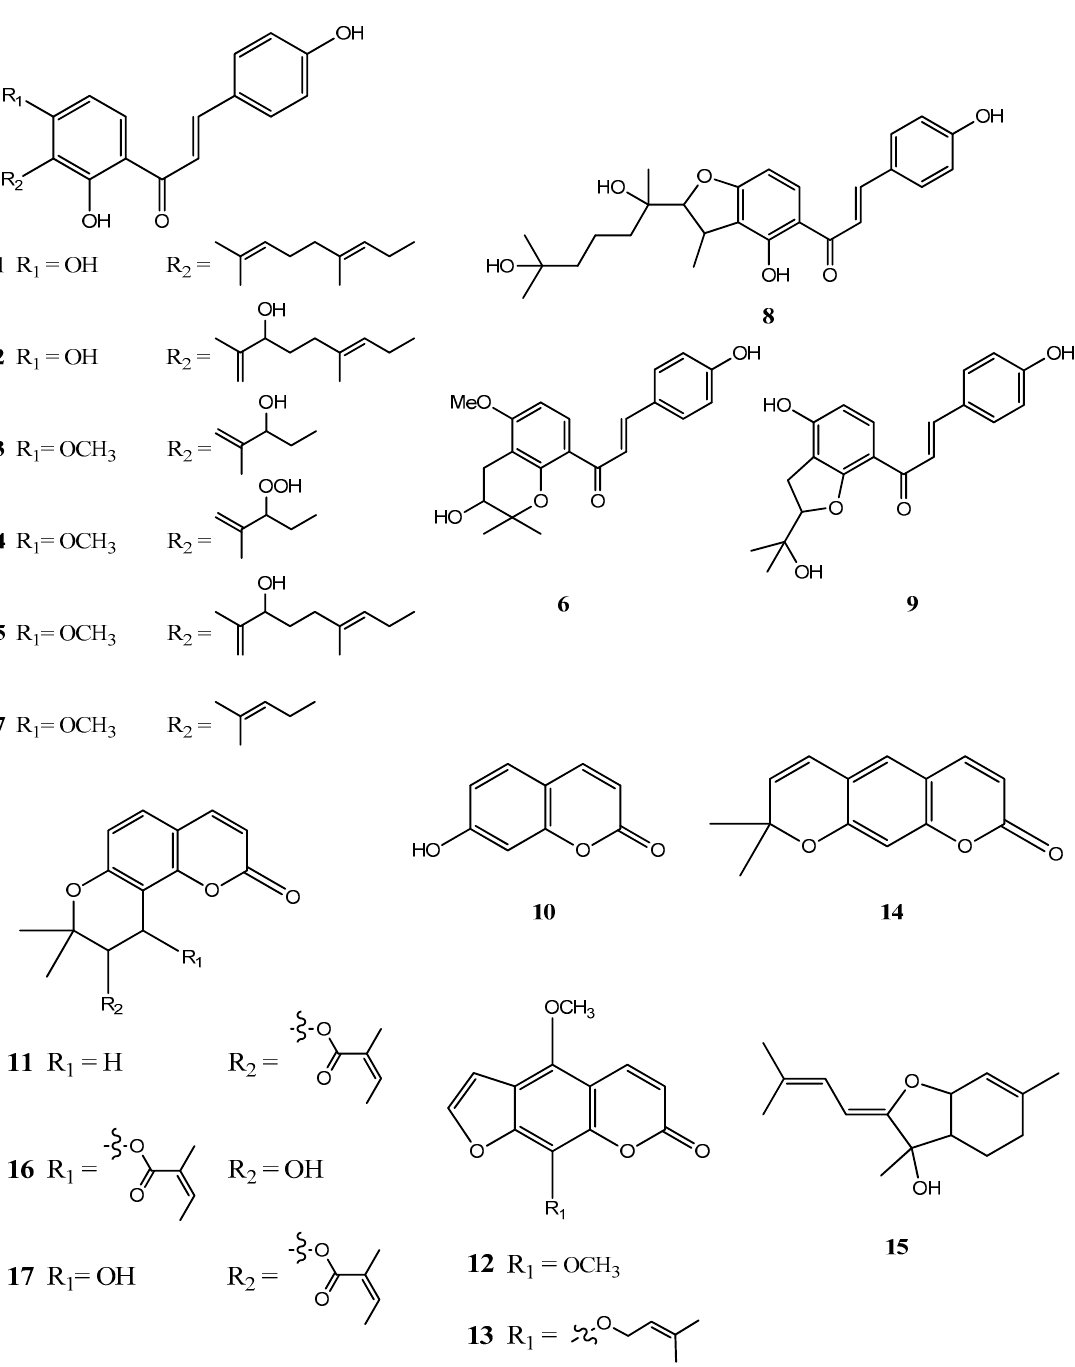
Figure 5. The chemical structure of 17 compounds in Angelica keiskei Koidzumi, xanthoangelol ( 1 ), B ( 2 ), D ( 3 ), E ( 4 ), G ( 5 ), H ( 6 ), 4-hydroxyderricin ( 7 ), xanthokeismin B ( 8 ), (2 E )-1-[4-hydroxy-2-(2-hydroxy-2-propanyl)-2,3-dihydro-1-benzofuran-7-yl]-3-(4-hydroxyphenyl)-2-propen-1-one ( 9 ), umbelliferone ( 10 ), selinidin ( 11 ), isopimpinellin ( 12 ), phellopterin ( 13 ), xanthyletin ( 14 ), ashitabaol A ( 15 ), laserpitin ( 16 ) and isolaserpitin ( 17 ).